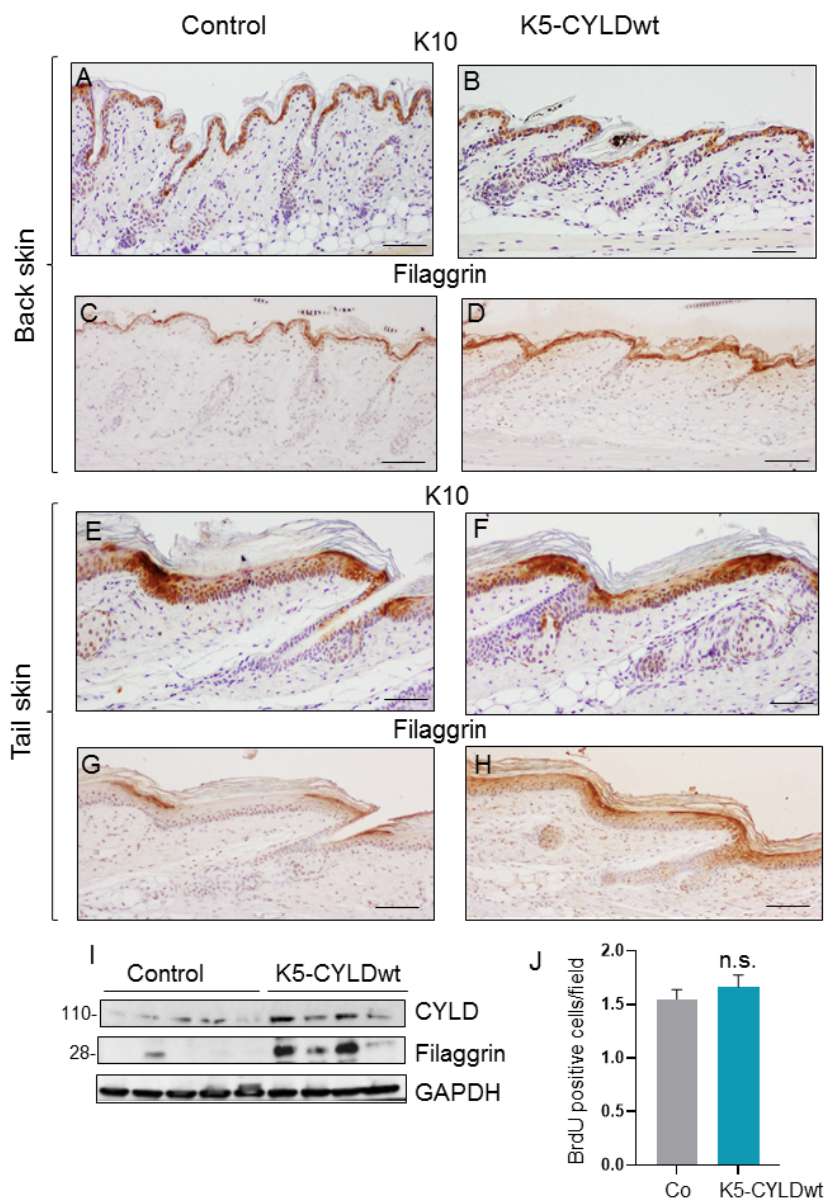
Figure 2. Analysis of skin differentiation and proliferation of transgenic mice. ( A ) Representative images showing the immunohistochemical analysis of the early ( A , B , E , F ) and terminal ( C , D , G , H ) epi- dermal differentiation in Control ( A , C , E , G ) and transgenic ( B,D,F,H ) mice, with specific antibodies against K10 and filaggrin, respectively. Staining of back ( A – D ) and tail ( E – H ) skin sections of 21- day-old mice is shown. Note the increased expression of filaggrin in both back and tail skin of K5-CYLDwt mice compared to Control mice ( I ). WB of total protein extracts from the back skin of Control and transgenic mice showing increased filaggrin expression in K5-CYLDwt mice. ( J ) The proliferation rate of keratinocytes was analyzed by BrdU incorporation, and no significant differences were found between the number of proliferating cells in the back skin of 6-month-old Control and transgenic mice. Five animals of each phenotype were analyzed. Data are shown as mean ± standard error of the mean (SEM) by two-tailed Mann–Whitney-test; n.s.: statistically not significant. Scale bars: 100 µ m ( A – D ); 70 µ m ( E – H